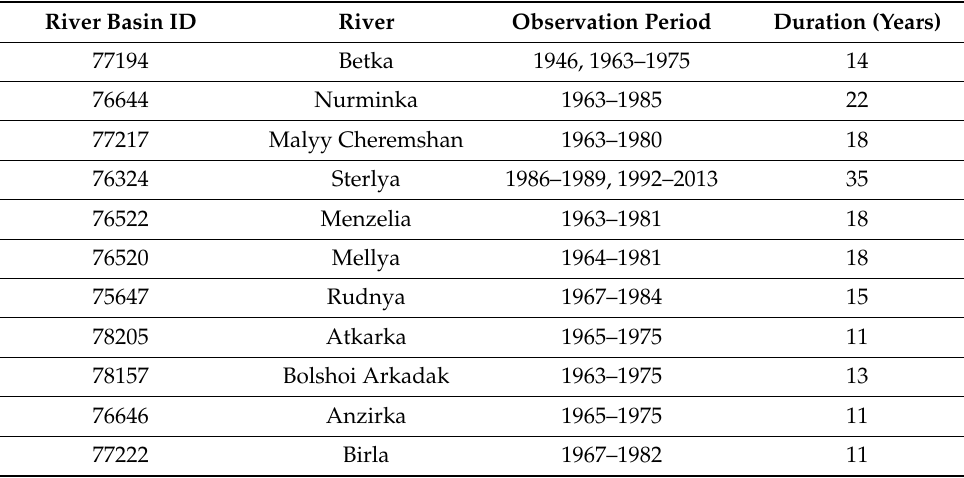
Table 3. Years of observation of suspended sediment